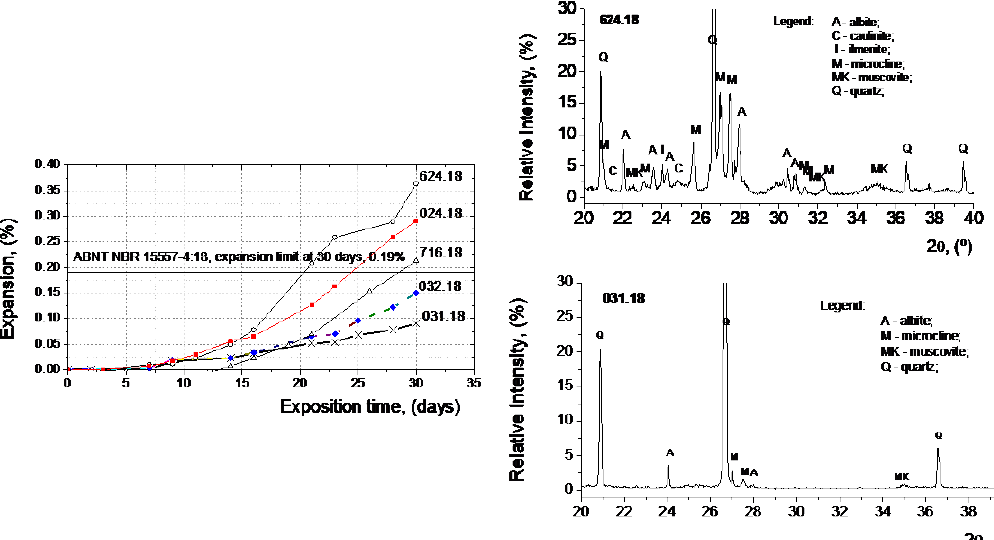
Figure 2. ASR potential reactivity for sand samples on the left. On the right, the XDR results for samples with the highest (624.18) and lowest (031.18) expansion rates.